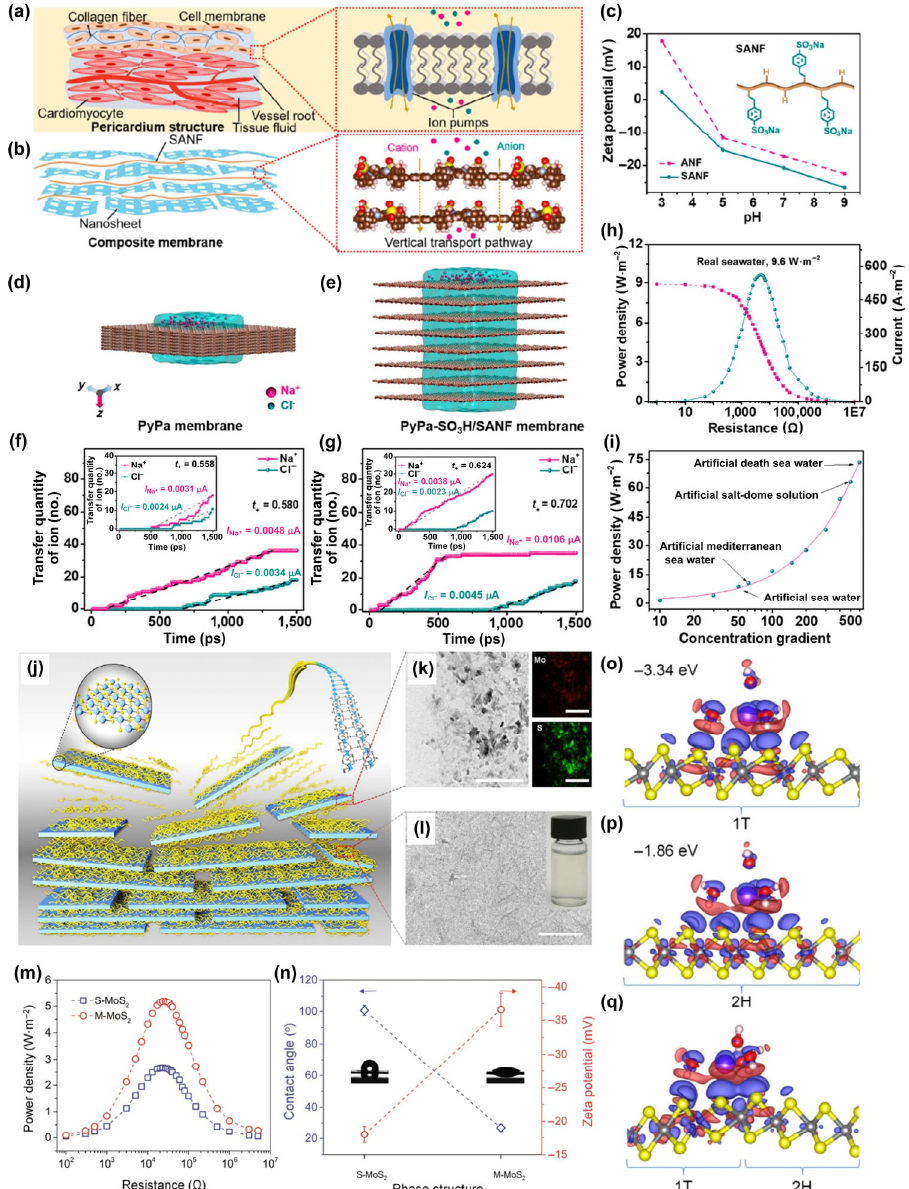
Figure 6 Schematic illustration of the pericardium structure (left) and the ion pumps on the cell membrane (right) (a). Schematic of PyPa-SO 3 H/SANF membrane (b). Zeta potentials of ANF and SANF (c). MD simulations for ion diffusion across PyPa (d) and PyPa-SO 3 H/SANF (e). Transfer quantity of Na + and Cl − ions in the vertical direction for PyPa (inset, horizontal directions) (f). Transfer quantity of Na + and Cl − ions in the vertical direction for PyPa-SO 3 H/SANF (inset, horizontal directions) (g). Power density of PyPa-SO 3 H/SANF (natural sea water|river water) (h). Power density of PyPa-SO 3 H/SANF for various concentration gradients (i). Reproduced with permission from Ref. [74], © American Chemical Society 2021. Schematic of the assembly of MoS 2 /CNF composite membrane (j). TEM and elemental mapping of MoS 2 nanosheets (scale bars are all 1 μm) (k). TEM of CNF (scale bar, 500 nm) (l). Osmotic energy conversion of S-MoS 2 and M-MoS 2 (m). The comparison of zeta potential and water contact angle measurements, where M-MoS 2 shows a higher surface charge and hydrophilicity compared with S-MoS 2 (n). The adsorption of hydrated cation on the surface of metallic-1T (o) and semiconducting-2H phase (p). For the coexistence of the two phases of MoS 2 , the mobile cations tend to adsorb on the surface of 1T phase (q). Reproduced with permission from Ref. [75], © American Chemical Society